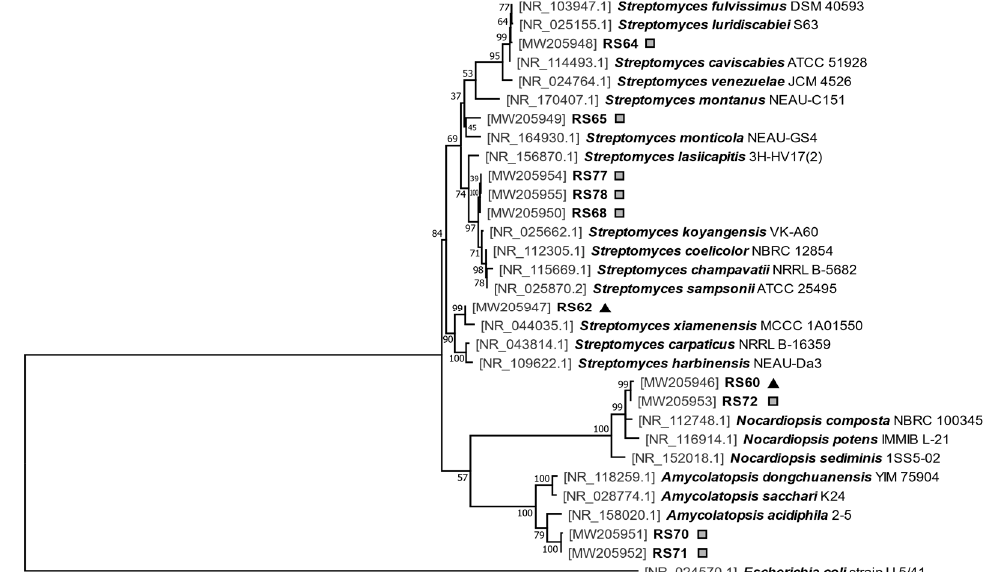
Figure 2. Phylogenetic analysis. Maximum likelihood phylogenetic tree generated using 16S rRNA sequences (the sequence of E. coli was used as the outgroup). Accession numbers are shown in brackets. Branch length is measured in number of substitutions per site (Scale Bar = 0.1). Bootstrap values based on 1000 replicates are shown next to the nodes. The actinomycetes isolates from the feces of C. welensii are marked with squares, while the isolates from the intestine are marked with triangles. Several isolates clustered together in the 16S rRNA analysis and showed a similar phenotype (RS68, RS77 and RS78, RS60-RS72 and RS70 and RS71) (Figure 1) which indicates they are probably